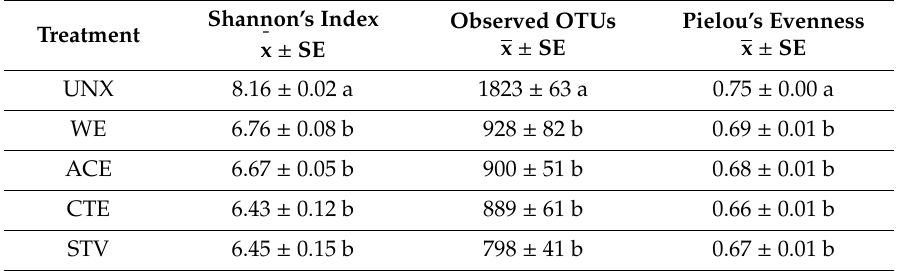
Table 2. E ff ect of treatment on alpha diversity and evenness of hindgut bacterial communities